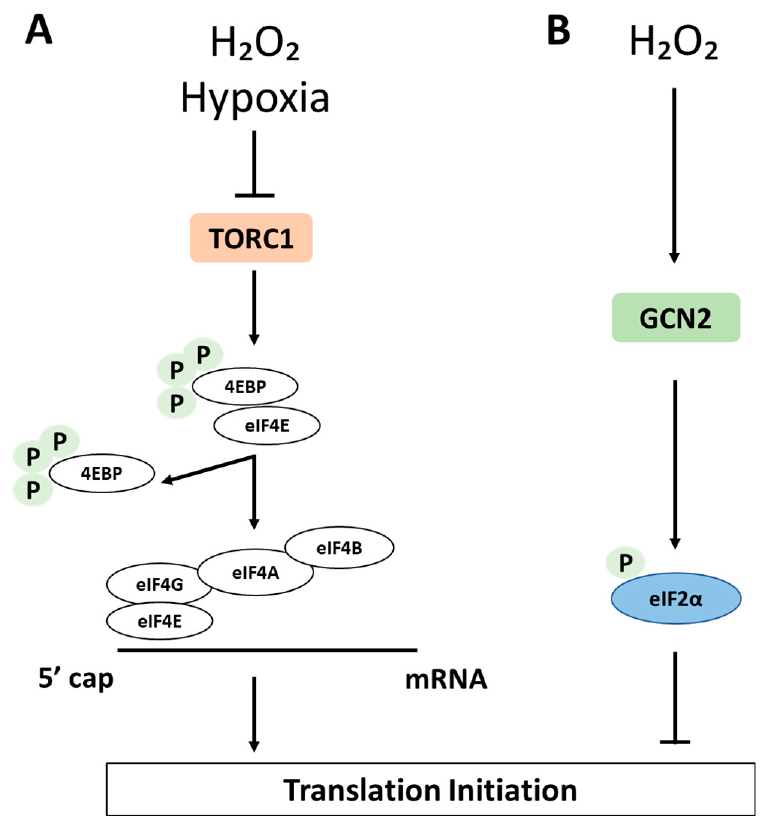
Figure 3. Impact of H ₂ O ₂ function on translation initiation. The TOR pathway. In mammalian cells, H ₂ O ₂ and hypoxia inhibit protein synthesis through inhibition of 4E-BP ( A ). There is a partial overlap in target genes of both pathways for translation inhibition under H ₂ O ₂ conditions ( B ).